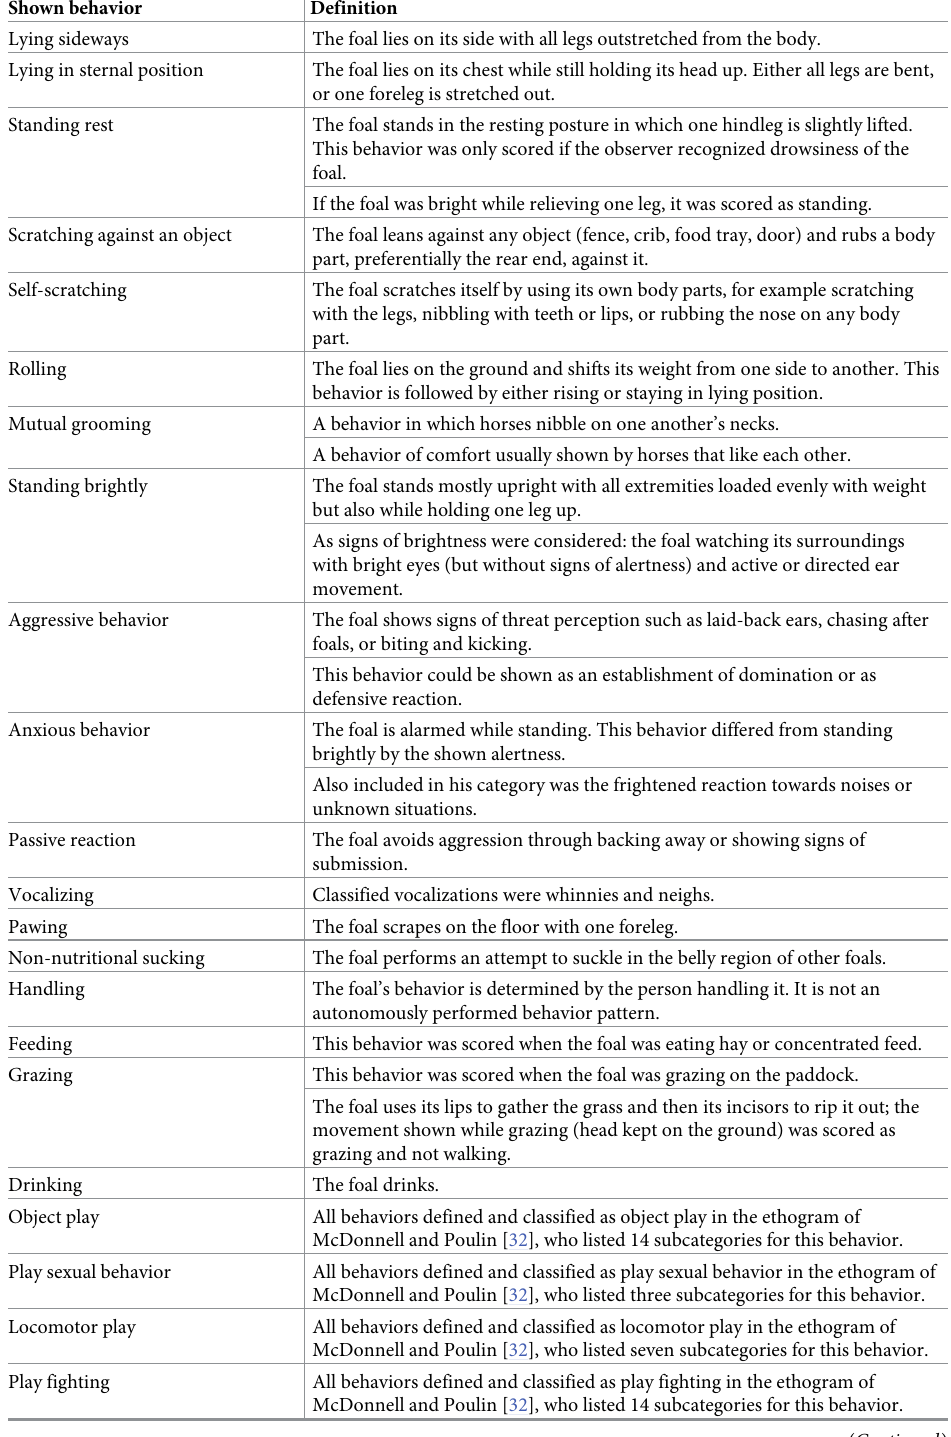
Table 2. Listing of displayed